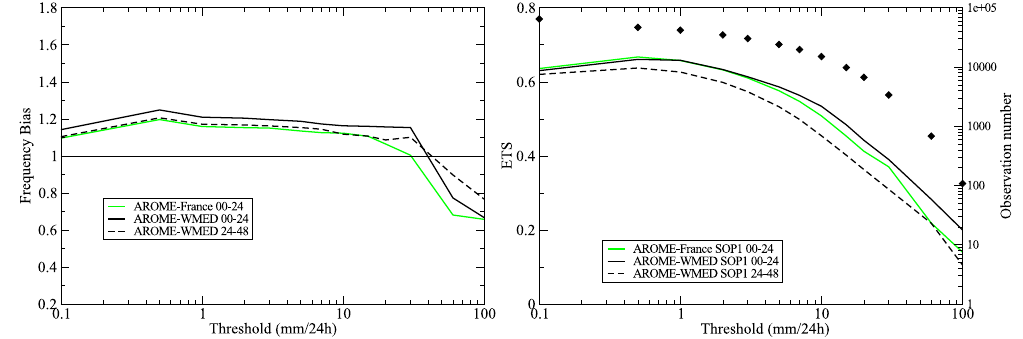
Figure 11. Frequency bias (left-hand side) and equitable threat score (ETS; right-hand side) for the 0–24h accumulated precipitation simu- lated by AROME-France (green line) and AROME-WMED (black line) and for the 24–48h accumulated precipitation predicted by AROME- WMED (dashed black line) during the SOP1 period from 05 September to 06 November 2012. Logarithm scale on x axis. Diamonds represent the number of observations used for the comparison.